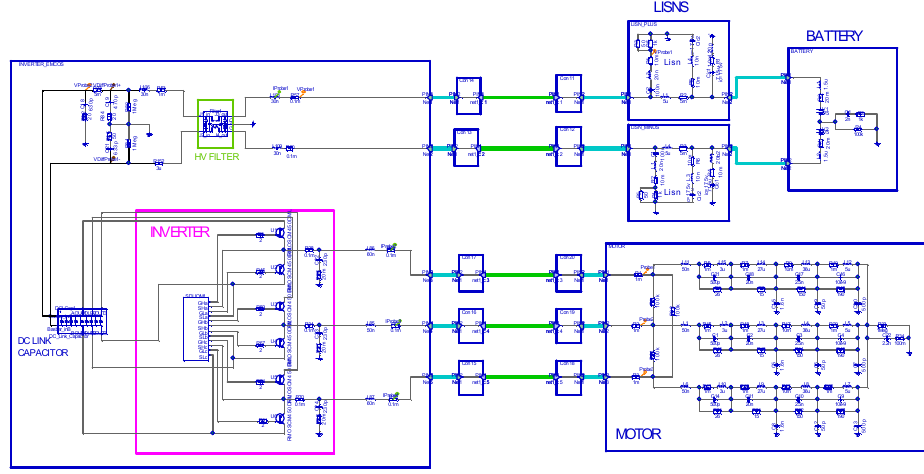
Figure 25. UQM Powerphase 100 setup model. The model is large and requires optimized transistor models. Thus, we used both a complex IGBT model (CM450DX; Figure 5) and a simple model (RMOS450DX; Figure 21), the parameters of which we took directly from the transistor datasheet. Figures 26 and 27 show the modeling results. The simple transistor model did not differ much in the calculations, compared to the complex model. Therefore, we concluded that during the EMC pre-analysis of complex systems (e.g., the electrical wiring of a car, ship, aircraft, or other equipment), when it is necessary to detect and prevent parasitic resonances, it is sufficient to use the proposed simple model to save time.